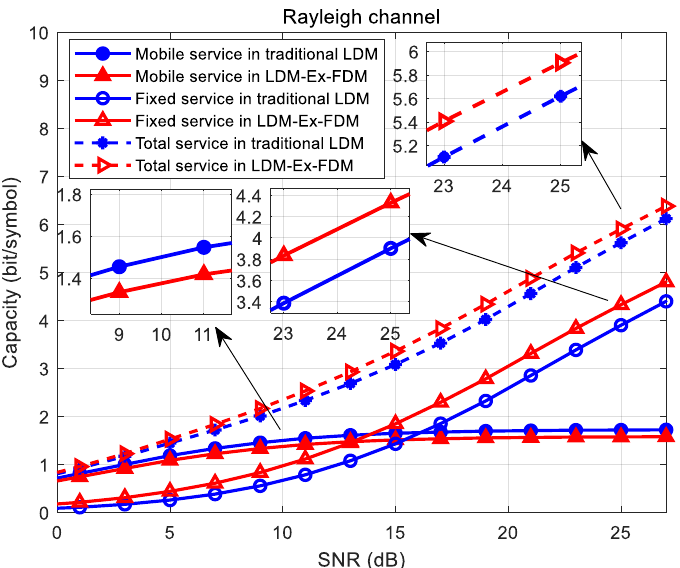
Figure 9. Capacities of mobile service and fixed service in Advanced Television System Committee (ATSC) 3.0 system with and without LDM-Ex-FDM scheme over the additive white Gaussian noise (AWGN) channel, where the parameter of ATSC 3.0 system was set to  = 10 dB, the CL constellation was set to QPSK, the EL constellation was set to NU−64QAM, and the puncturing rate of the LDM-Ex-FDM scheme was set to 1/12.